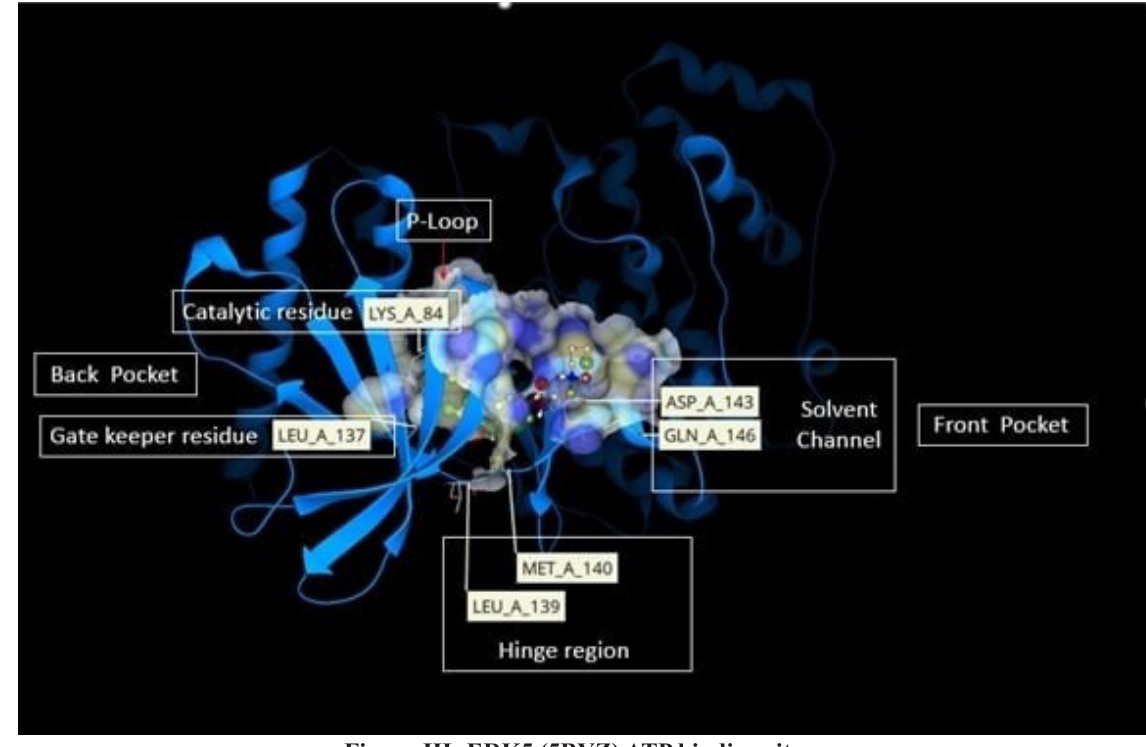
Figure-III: ERK5 (5BYZ) ATP binding site.